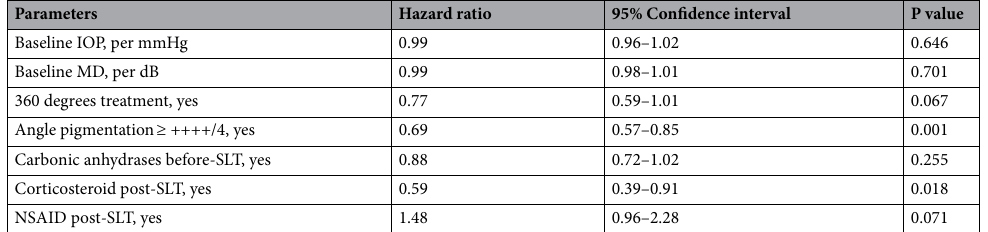
Table 5. Multivariable analysis of factors associated with failure after selective laser trabeculoplasty treatment. IOP intraocular pressure, MD mean deviation, SLT selective laser trabeculoplasty, NSAID nonsteroidal anti- inflammatory